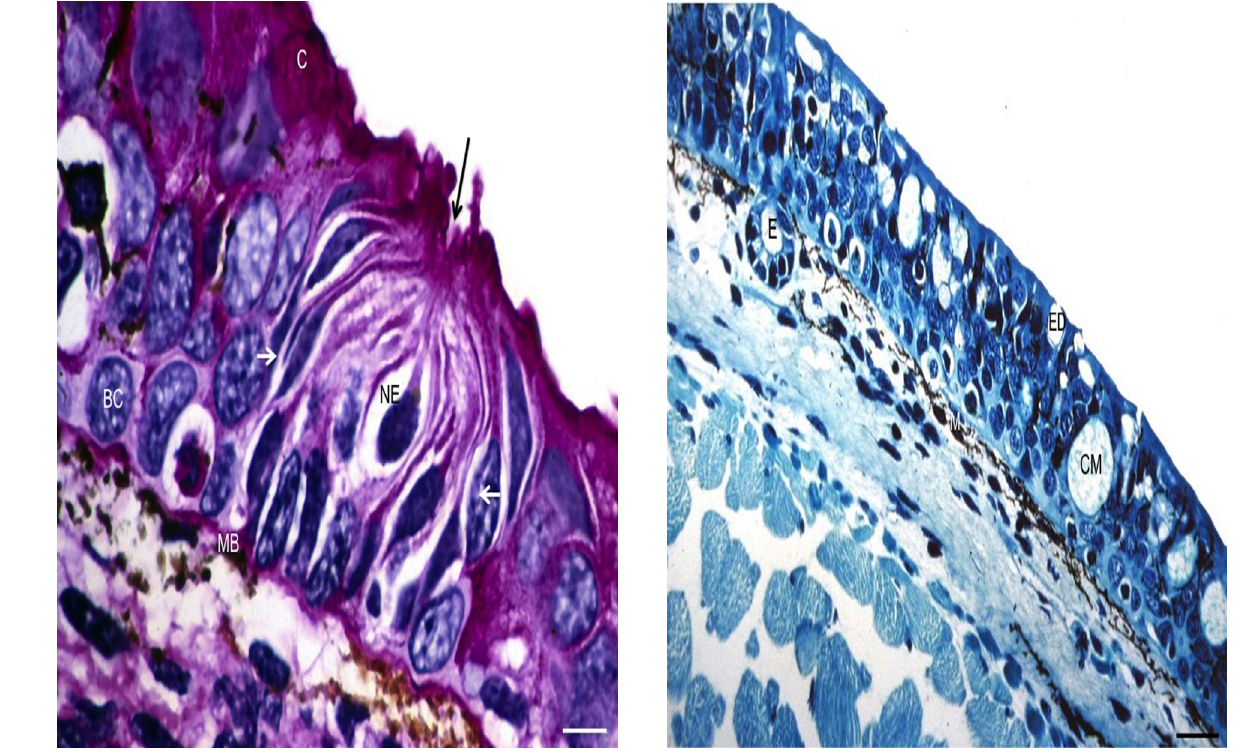
Figure 7 - Skin of dorsal region of L. paradoxa . At the dermoepidermal border, a tubule of an electroreceptor with a double layer of cuboidal cells (e) is visible; in the epidermis, mucus-secreting (MC) cells are visible, along with the duct of an electroreceptor (ED). Kuhn blue. Bar: 100 μm.